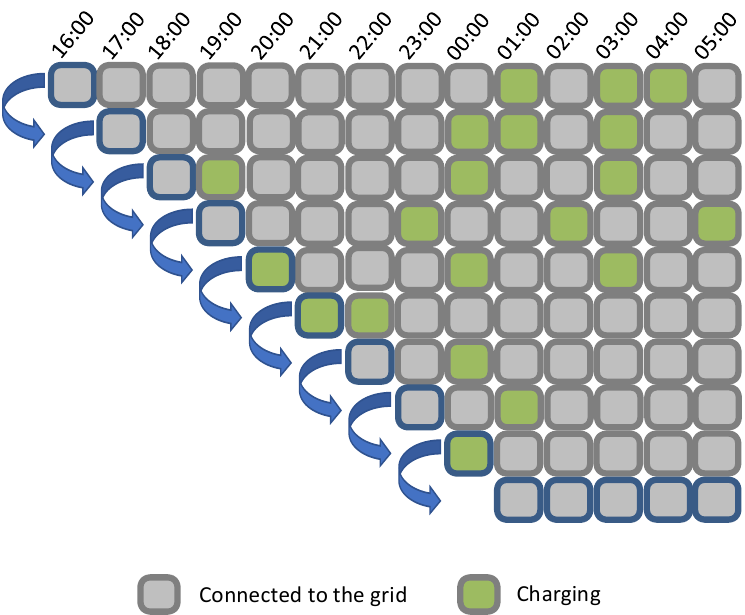
Figure 5. EVs’ updated charging plan due to new arrival forecasts.